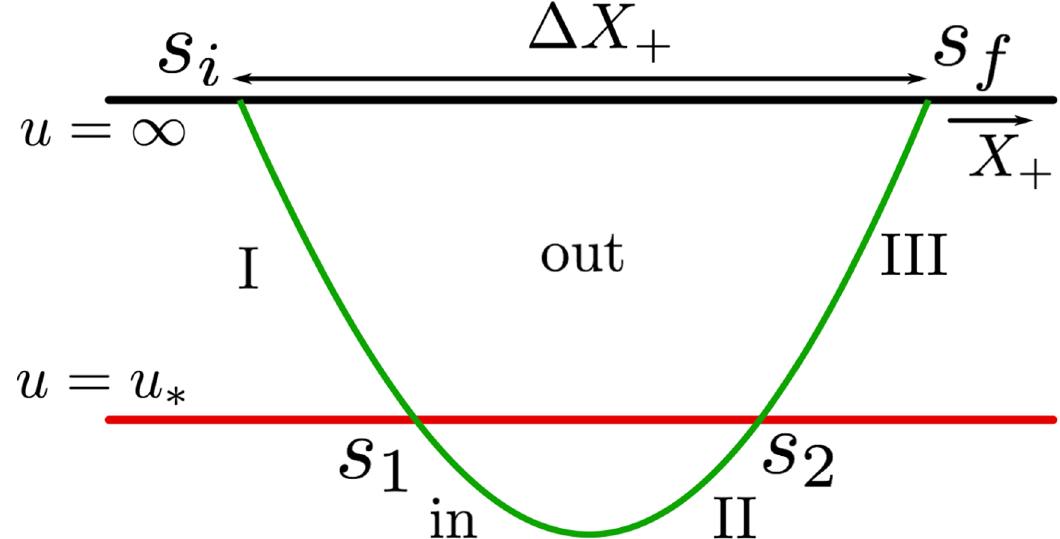
Figure 5 . The geodesic (green line) starts from the boundary at time s i , crosses the shell (red line) at times s 1 and s 2 and ends at the boundary at time s f . The latin numbers denote di(cid:11)erent segments of the